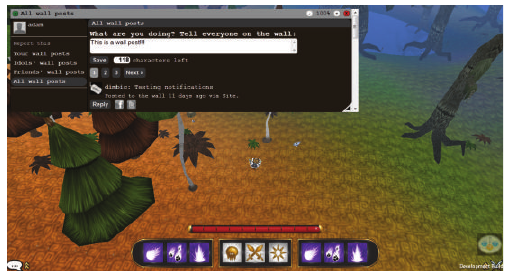
Figure 5: The same game with integrated CNG collaboration tools, where widget panes are in horizontal